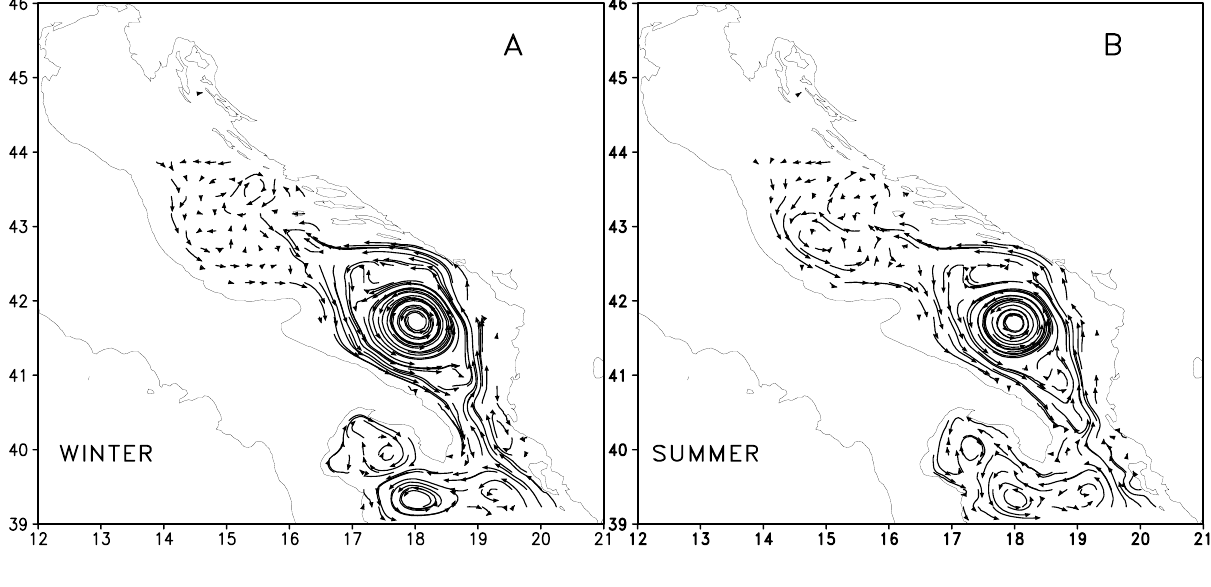
Fig. 8. Adriatic Intermediate Model (AIM). Seasonal velocity trajectories at 75m depth computed as if the flow were steady for 10 days. (A) : winter, (B) : summer. Not all the grid points have been plotted. Seasons definition as in Artegiani et al. (1997a,